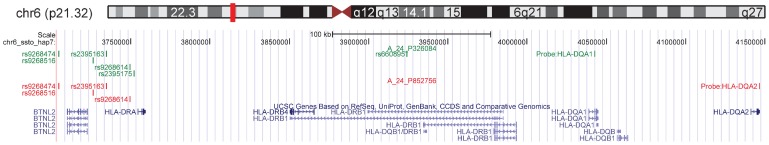
HLA region probes and SNPs involved in significant cis eSNP relationships.Two probes in the HLA region on chromosme 6 showing significant association with PD risk SNPs are shown on the alternative sequence haplotype chr6_ssto_hap7. Six PD risk SNPs (shown in green) showed significant association to A_24_P326084 located in HLA-DQA1, while four SNPs (shown in red) had significant association to A_24P852756, located in HLA-DQA2.